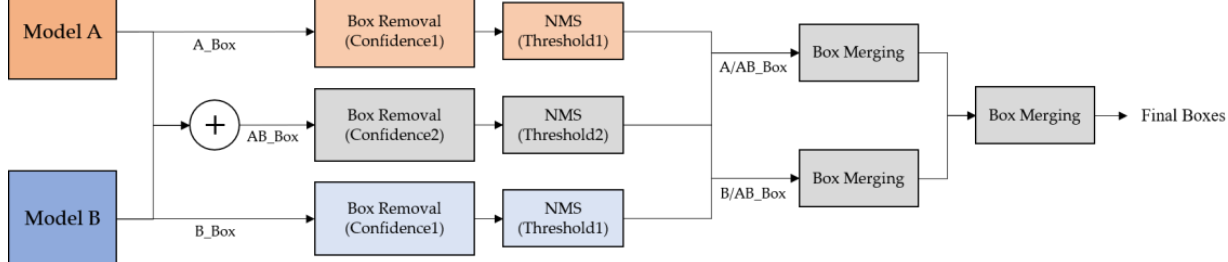
Figure 4. Structure of model ensemble.